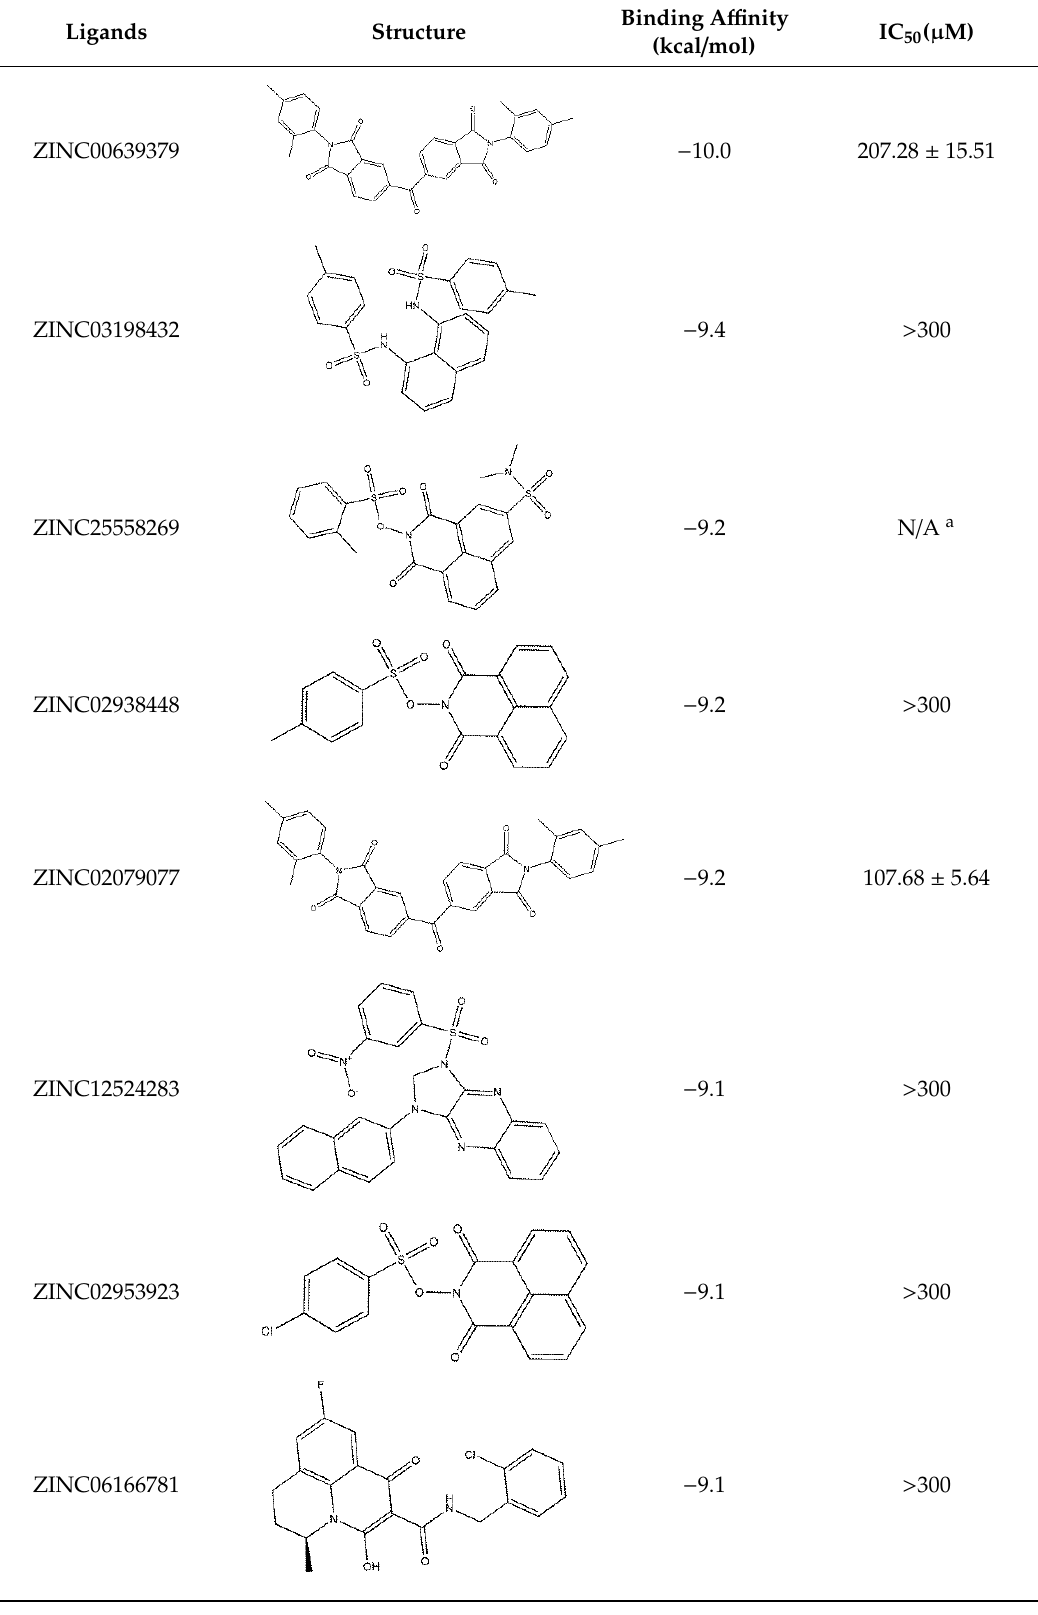
Table 1. Screen 18 ligands during virtual screening and inhibition ratio.